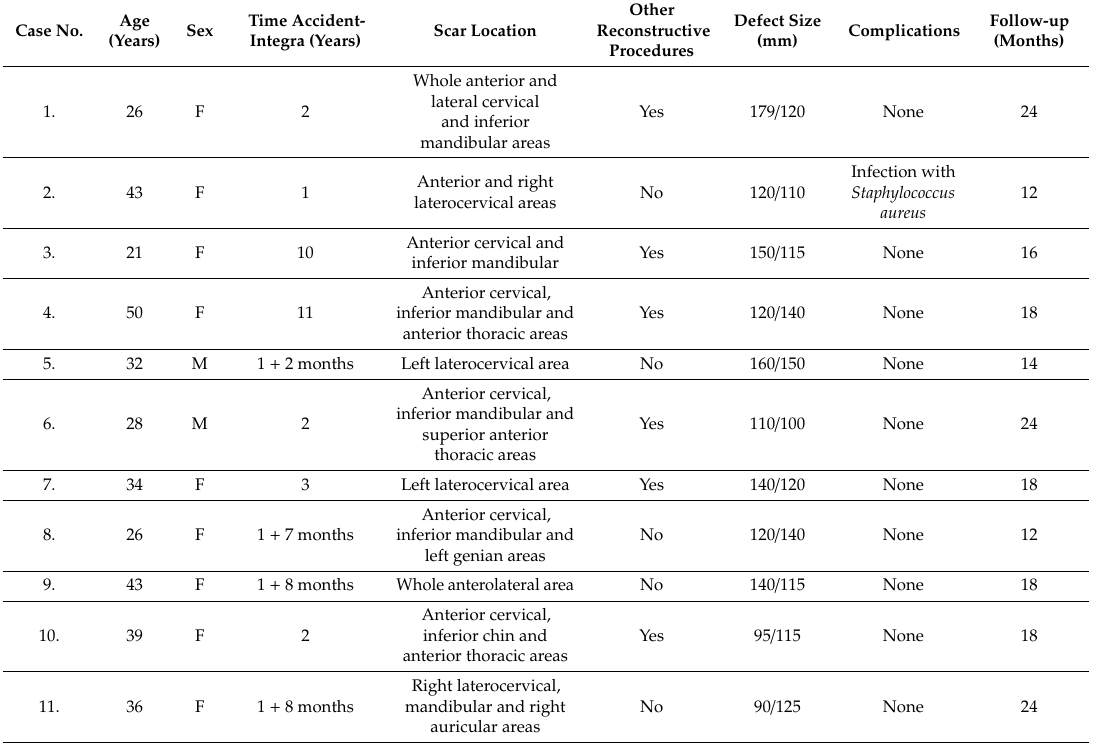
Table 1. Using Integra for the reconstruction of neck regions of eleven cases followed up. Case